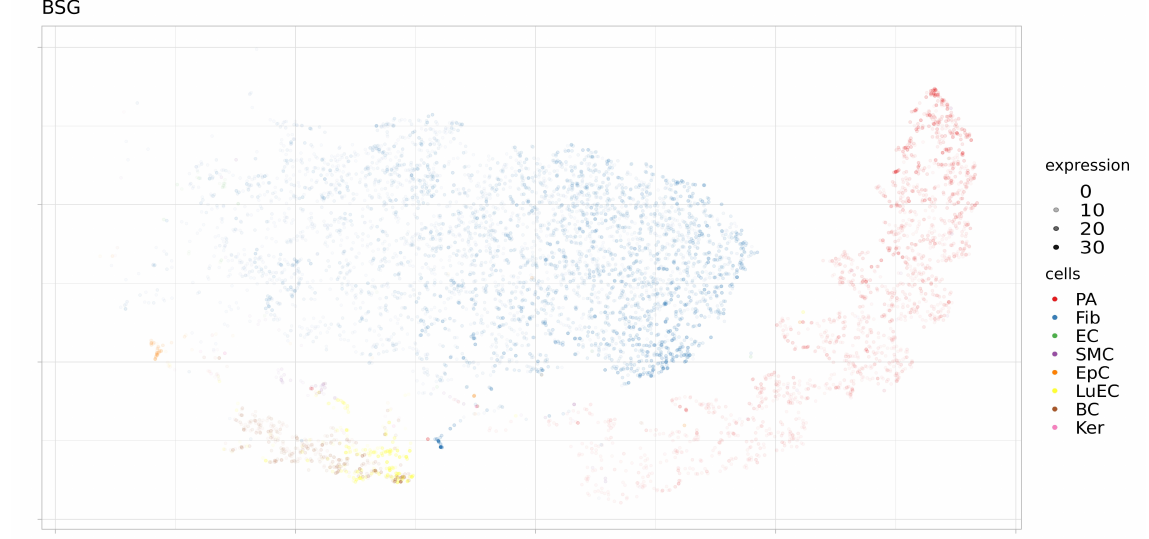
Figure 8. Expression levels BSG in separate cells of proximal stromal lung (SRS2769051). PA, pulmonary alveolar type II cells; Fib, fibroblasts; EC, endothelial cells; SMC, smooth muscle cells; LuEC, luminal epithelial cells; BC, basal cells; Ker, keratinocytes. Color intensity indicates the level of expression in a single